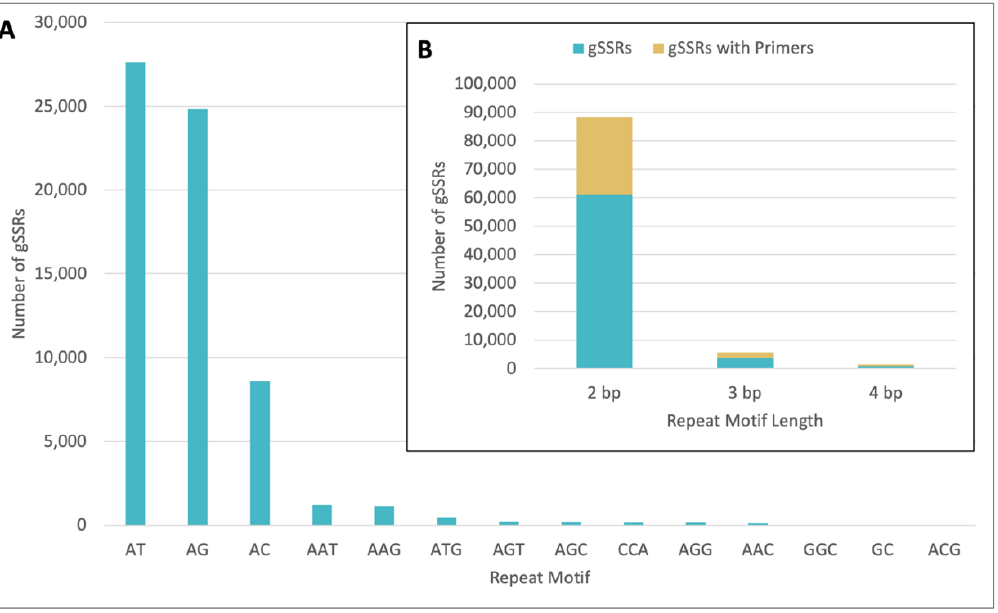
Figure 1. Genomic SSRs (gSSRs) mined from the de novo assembled genome of Weigela Spilled Wine ® . Overall number of 2 bp and 3 bp gSSRs identified are shown in blue broken down by repeat motif ( A ). Distribution of 2 bp, 3 bp, and 4 bp repeat motif lengths for gSSRs (blue) and gSSRs with primers (gold) ( B ). bp = base pairs.